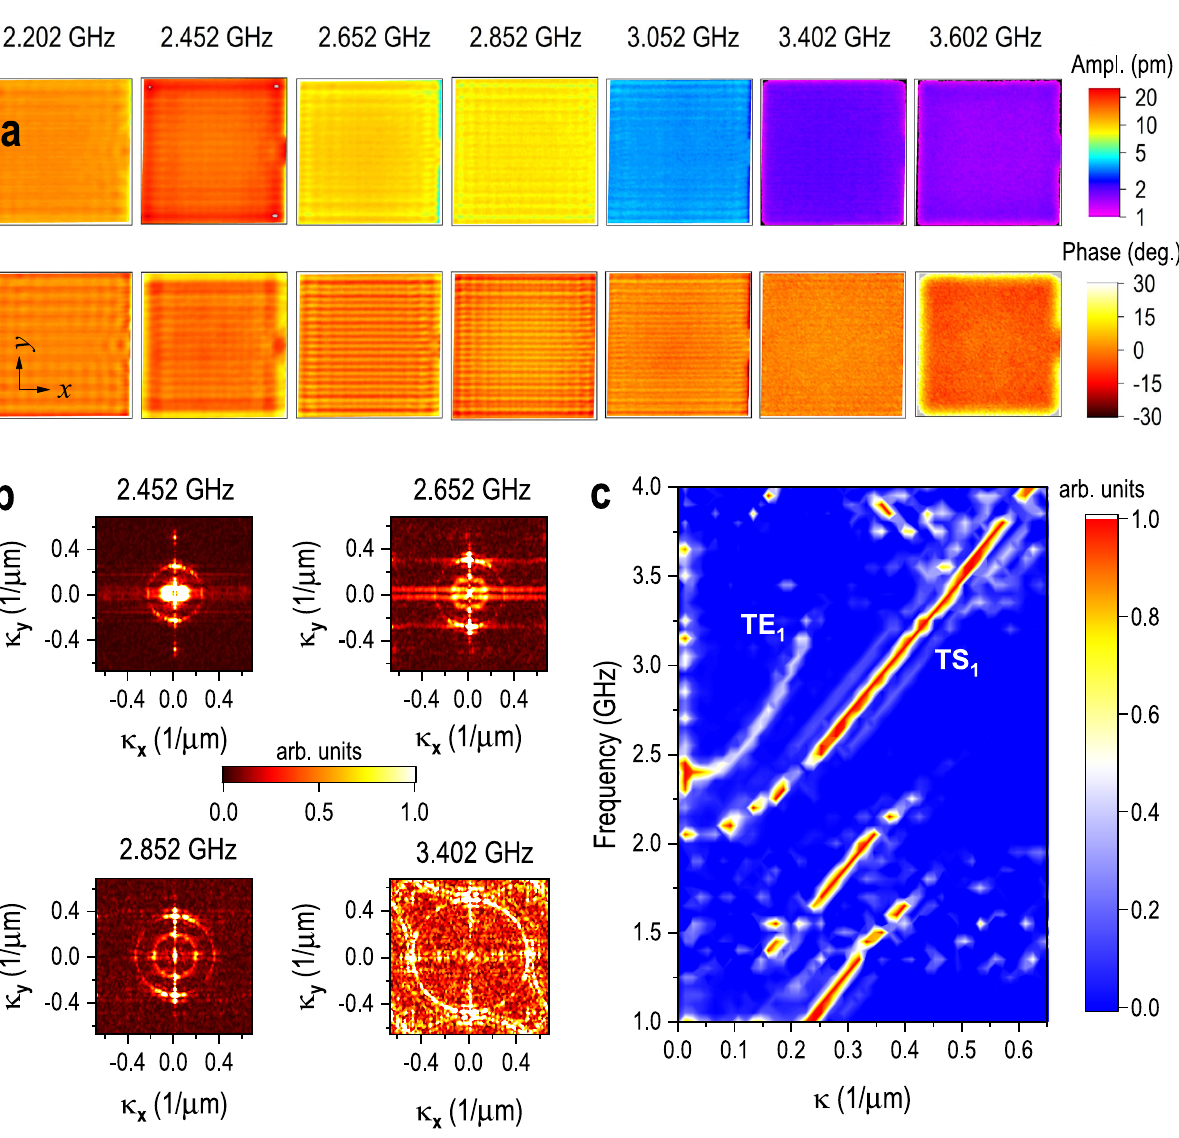
Fig. 5 Vibrational wave fi eld mapping and acoustic dispersion. a Mapping of vibration amplitude and phase of the BAW for a wide range of super high frequencies. b Spatial 2-dimensional fast Fourier transforms (2D-FFT) of the phase mappings for four representative frequencies. c Dispersion diagram extracted from the 2D-FFTs of the phase mappings from 1 to 4 GHz, showing four acoustic modes in the BAW. See Supplementary Note 5 for more data. TE 1 thickness-extensional mode, TS 1 thickness-shear mode. κ is de fi ned as 1/ λ a here, where λ a is the acoustic